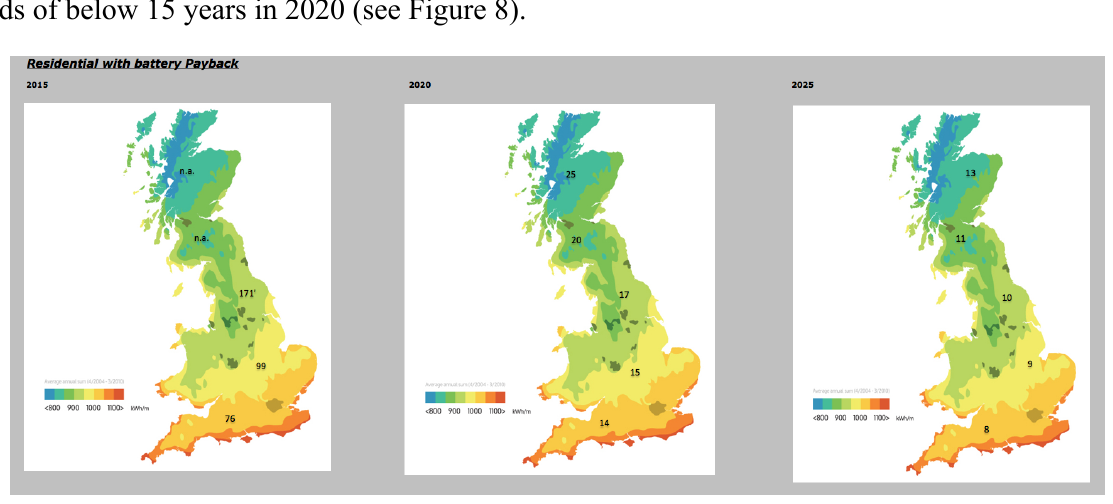
Figure 8. Projected solar battery pack payback periods, number of years,